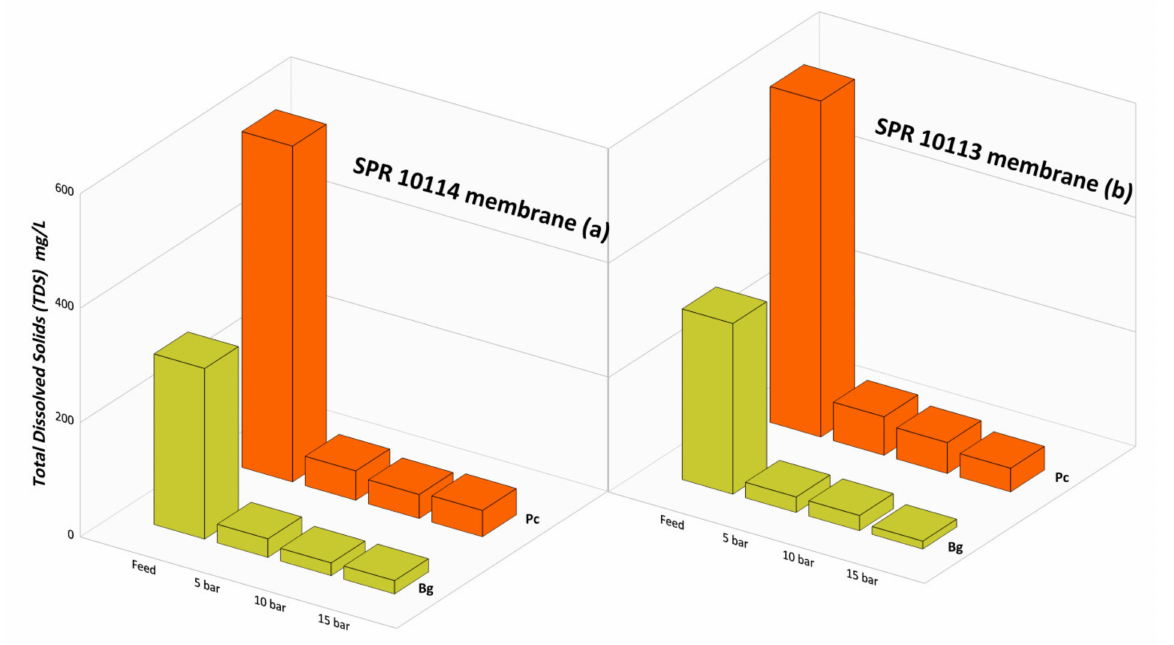
Figure 7. TDS content in the feed and permeates for the ( a ) SPR 10114 and ( b ) SPR 10113